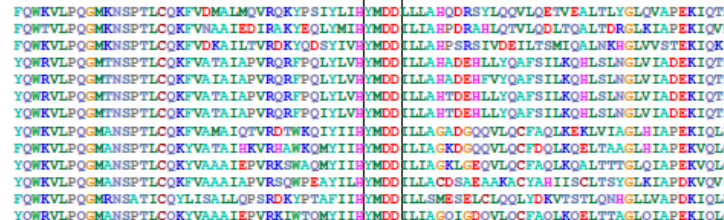
Figure 3. Alignment of translated pol sequences of EqERV-beta1 and reference beta- and delta-retroviruses. A pol fragment, corresponding to amino acid positions 147-226 in EqERV-beta1, surrounding the conserved YMDD motif (boxed) is shown. Accession number AC150855 (BAC CH240-472P12 from Bos taurus ) harbours a further unidentified endogenous retrovirus pol sequence (nt 6344-3579, minus strand) with large homology to EqERV-beta1 (as detected by a BLAST search of the entire nucleotide